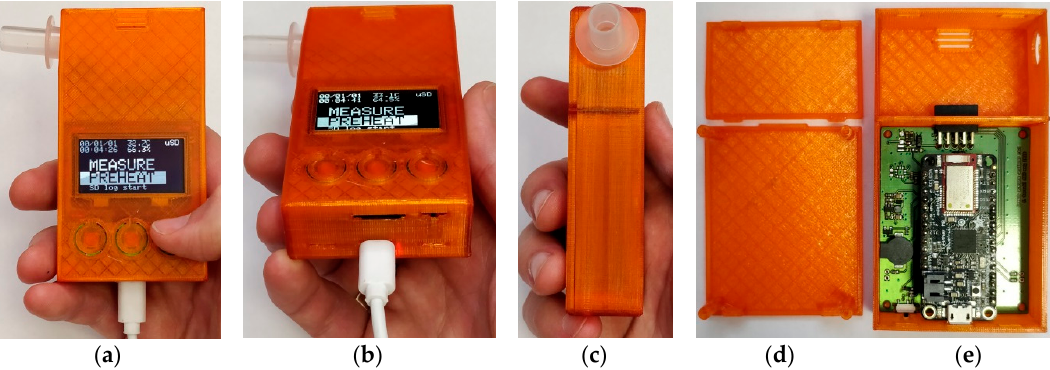
Figure 4. A photograph of the manufactured analyzer. Front panel ( a ), bottom view with connectors ( b ), side panel with a disposable mouthpiece ( c ), the gas chamber ( d ) and the electronics compartment (e).